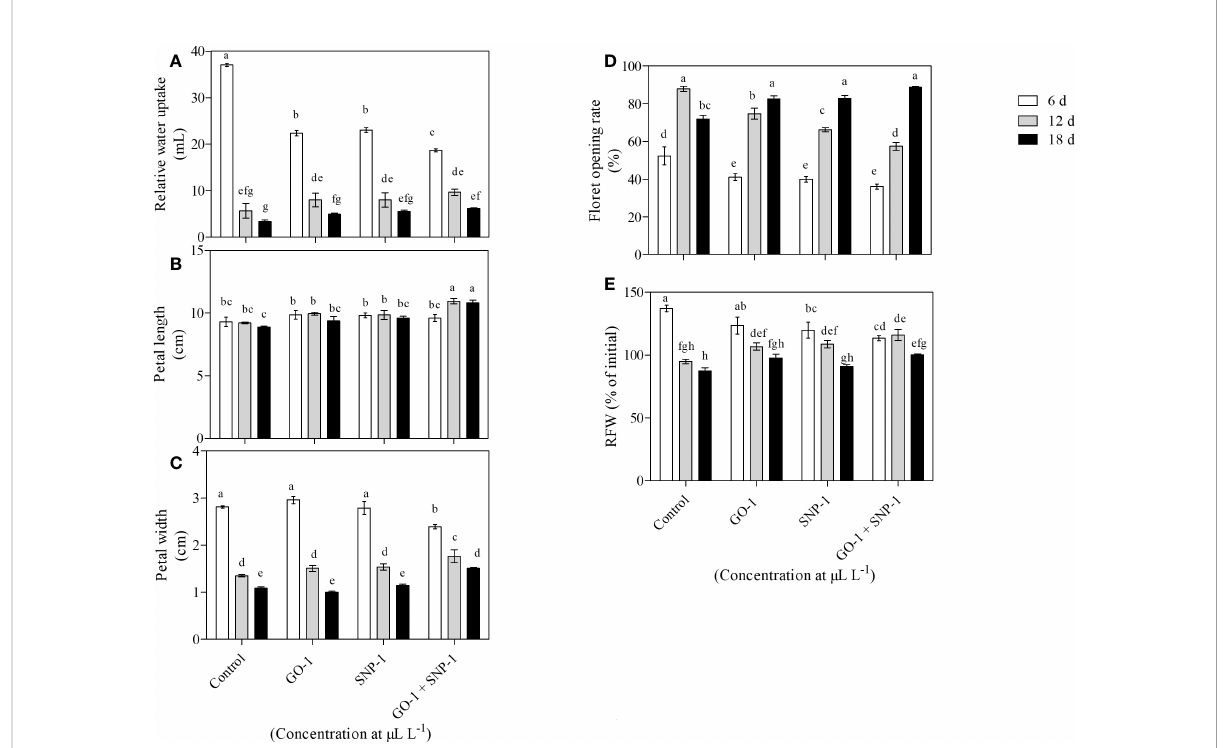
FIGURE 1 Effect of NPs, viz ., control, GO, SNP and GO + SNP at 1 µL L − 1 on various morpho-physiological parameters such as (A) relative water uptake, (B) petal length, (C) petal width, (D) fl oret opening, and (E) RFW. Results are shown as mean ± SE of three replicates. Means with different letters are signi fi cantly different (Duncan ’ s multiple range test, p = 0.05